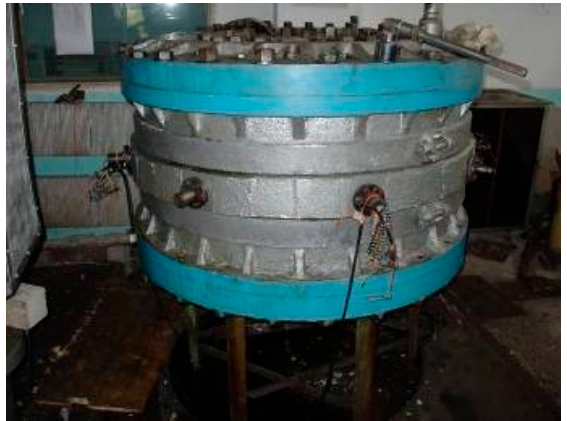
Figure 3. Well-processed shaft lining model. Figure 4. Loading device for simulation testing.